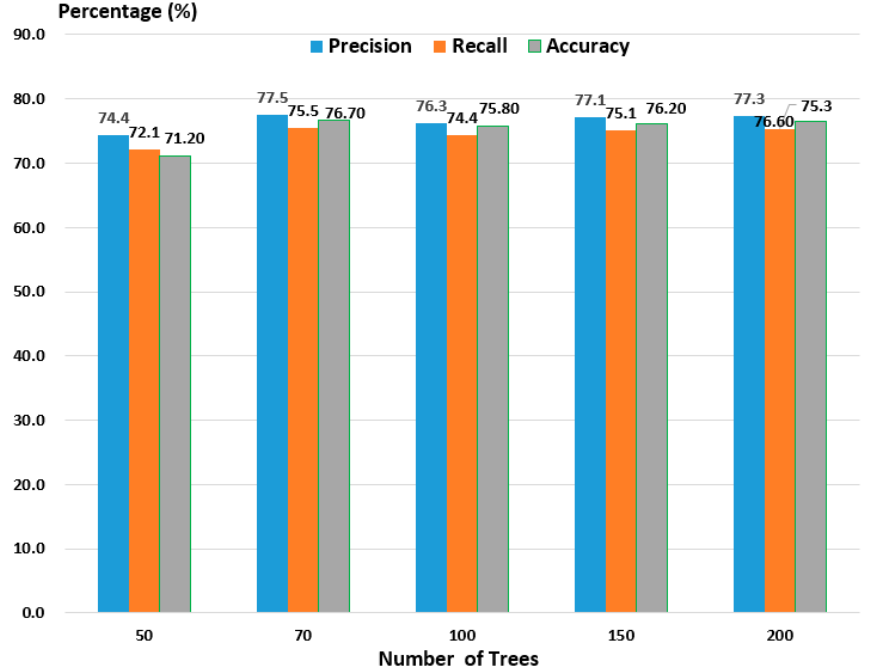
Figure 4. Five possible pairs of experiment results for determining the number of trees for the student